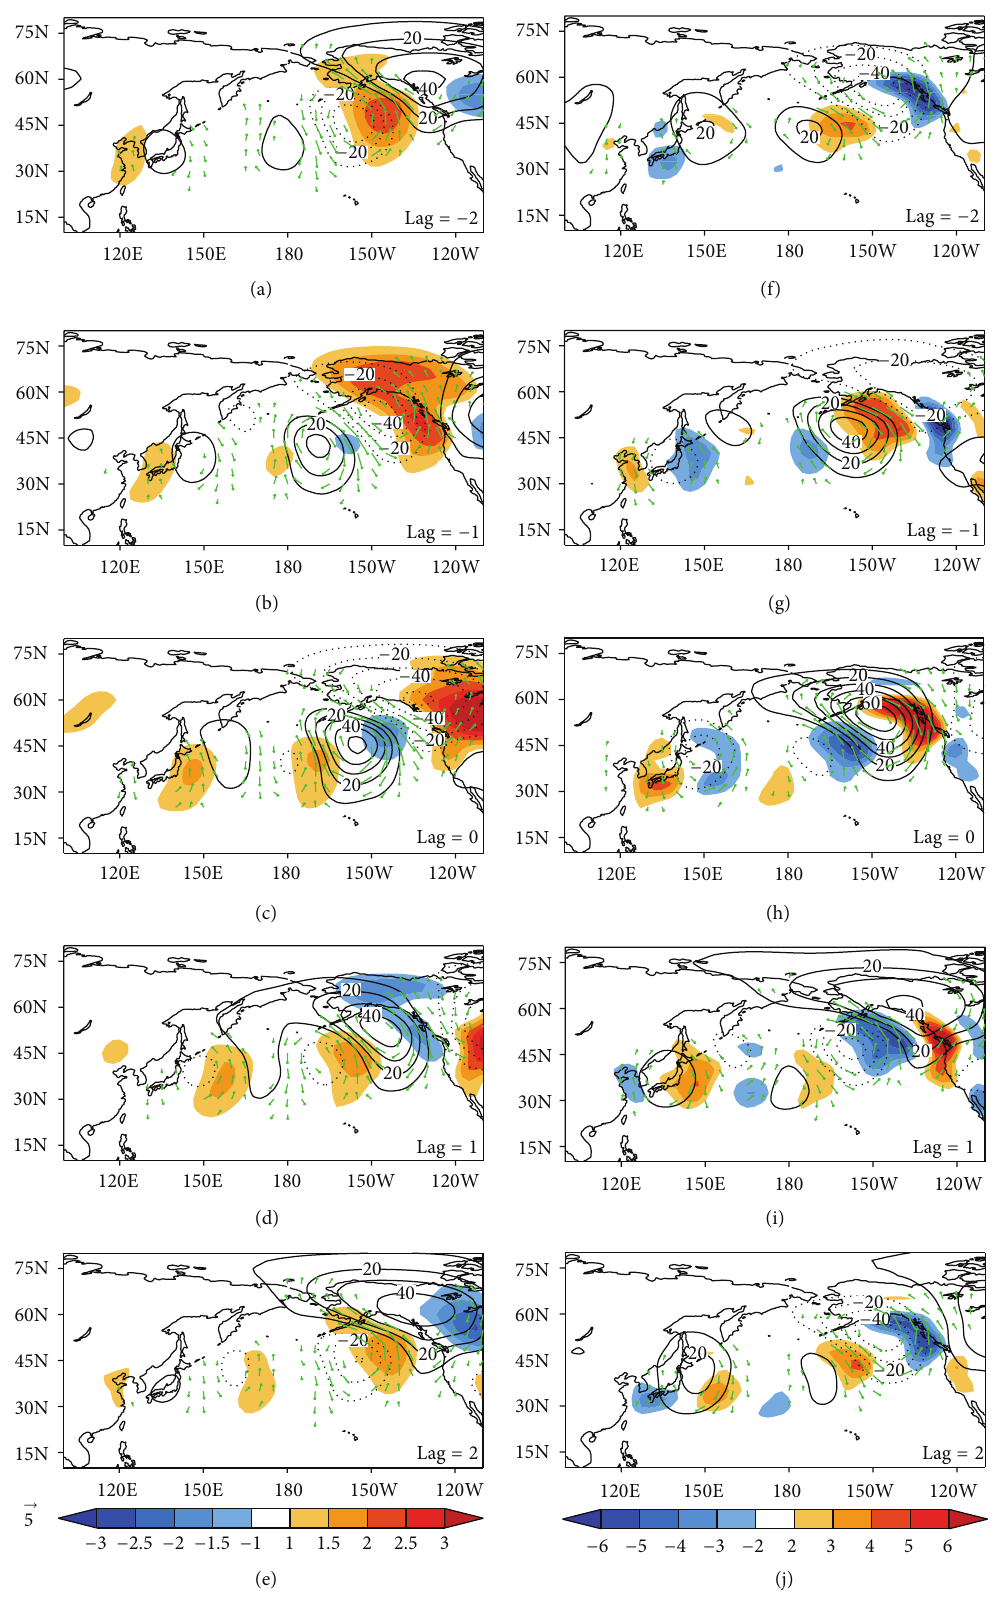
Figure 4: As in Figure 3, but for the PC3 > 2 (a, b, c, d, and e) and PC4 > 2 (f, g, h, i, and